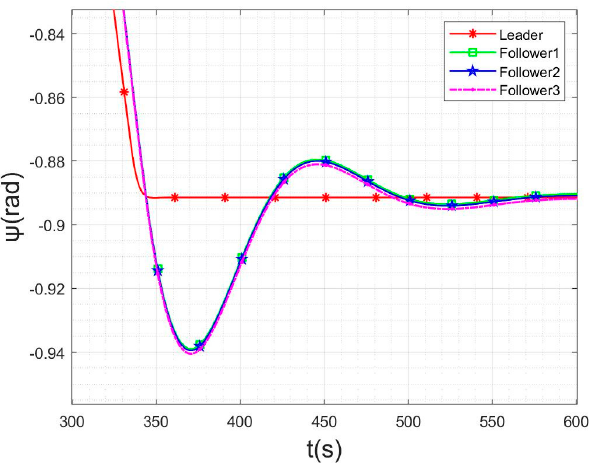
Figure 11. Follower heading control command tracking effect.